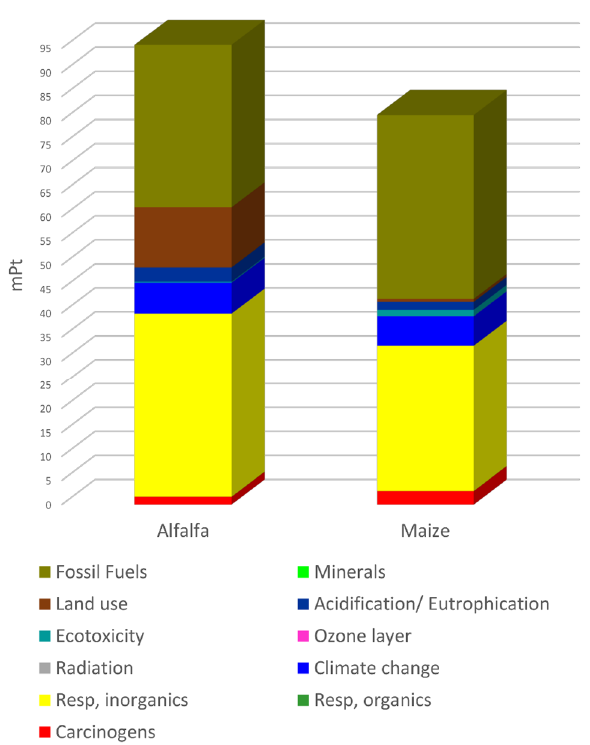
Figure 5. Comparison between the two crops in the characterization phases.